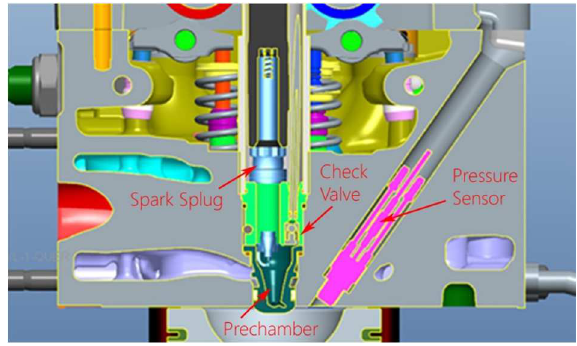
Fig. 3. CAD visualisation of the combustion chamber of the prechamber engine